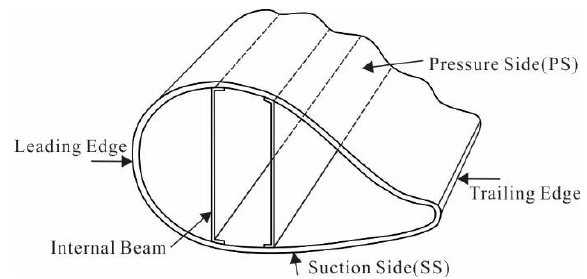
Figure 1. The wind turbine blade structure used in this research.